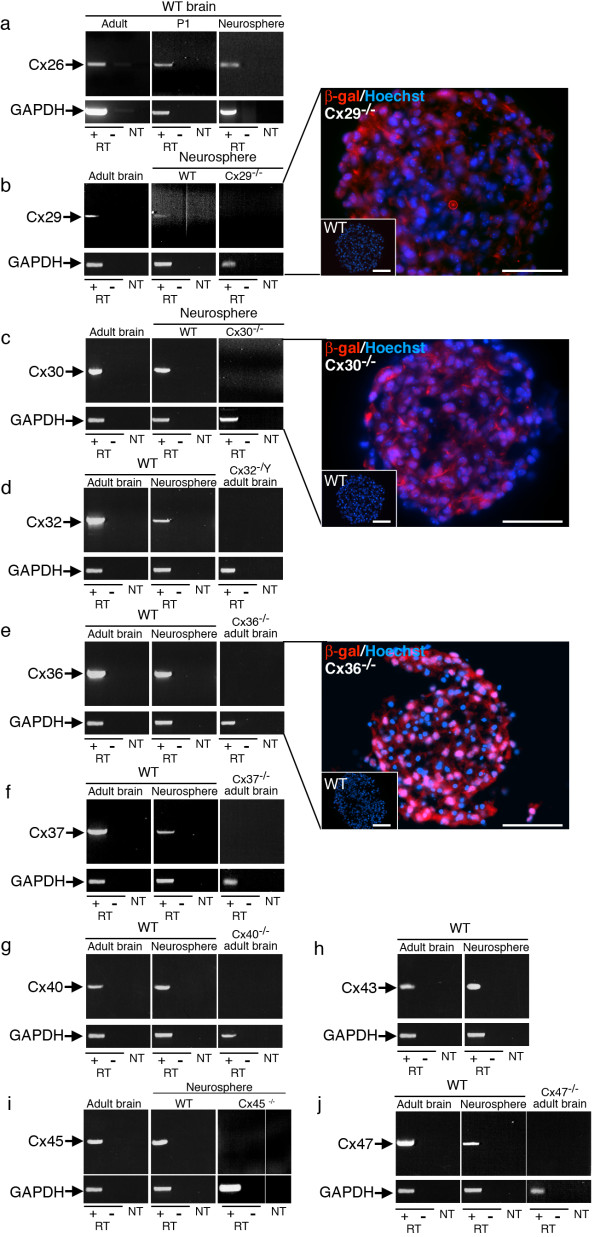
Connexin mRNA expression in postnatal hippocampal neurospheres cultured in the absence of exogenous ECM. RT-PCR analysis of Cx26 (a), Cx29 (b), Cx30 (c), Cx32 (d), Cx36 (e), Cx37 (f), Cx40 (g), Cx43 (h), Cx45 (i), and Cx47 (j) of random-primed RNA extracted from 100–150 pooled neurosphere cultures (+RT). GAPDH was amplified to confirm template integrity. Positive controls were: Total RNA isolated from adult and/or P1 WT whole brain. Negative controls included RT-PCR reactions performed on total RNA from null-mutant neurospheres (Cx29-/-, Cx30-/-, and Cx45-/-) or adult brain (Cx32-/Y, Cx36-/-, Cx40-/-, Cx37-/-, and Cx47-/-), and reactions processed in the absence of template (NT). Potential contamination by genomic DNA was assessed by omitting the RT enzyme from the reactions (-RT). In a, c, and e, panels depict neurosphere cryosections derived from Cx29-/-, Cx30-/-, and Cx36-/- animals processed for β-galactosidase immunocytochemistry. The LacZ gene replaces the connexin coding sequence in each of these null-mutant animals. Insets are antibody controls demonstrating WT sections are negative for the β-galactosidase marker. Scale bars, 50 μm.